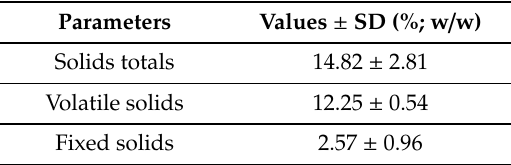
Table 4. Characterisation of substrate (cow manure + corncob hydrolysate).